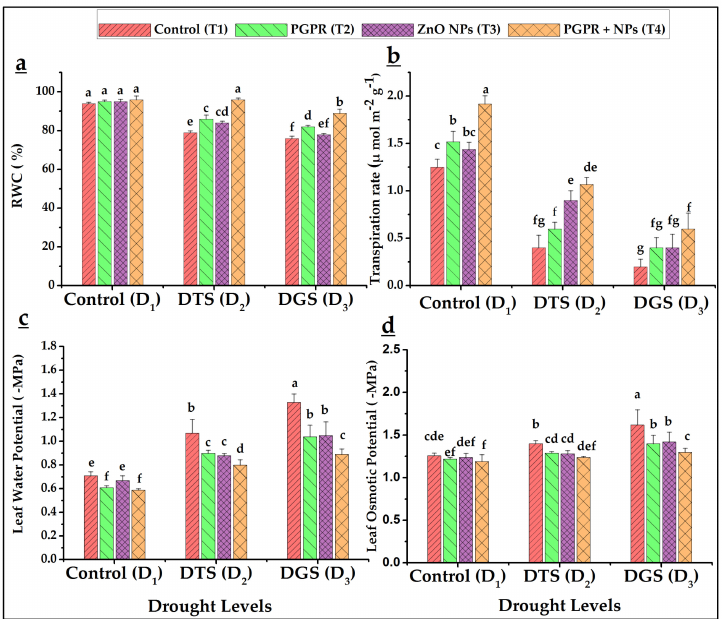
Figure 2. Effects on relative water content modifications RWC ( a ), transpirational rates ( b ), fo- liar water and osmotic potentials ( c , d ) in drought-subjected wheat by single and co-applied ZnO NPs and Azospirillum brasilense (PGPR). DTS = drought at tillering, DGS = drought at grain filling, T 1 = control, T 2 = single use of Azospirillum brasilense , T 3 = single use of ZnO NPs, and T 4 = co-application of PGPR and NPs. Error bars indicates standard error ( n = 3). (Note: Different lowercase letters indicate significant differences between different drought levels and treatments by the LSD test at p <